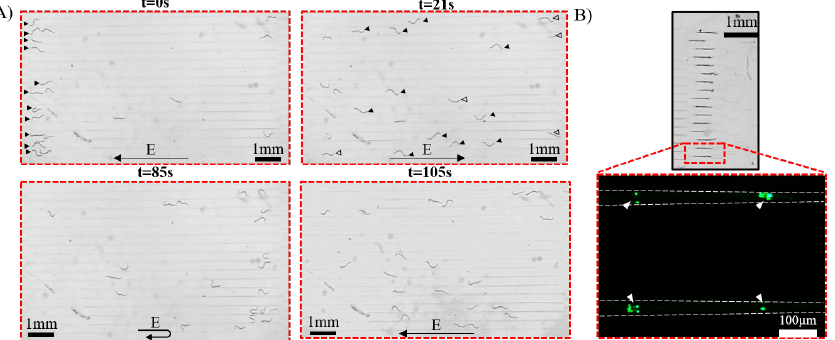
Figure 3. ( A ) Time-lapse images showing electrotaxis of N2 worms in parallel channels after exposure to 250 µ M 6-OHDA. Black arrows indicate worms responding towards the cathode, while empty arrows show worms with different phenotypes, such as uncoordinated movement and sudden freezing due to 6-OHDA exposure (EF = 3.7 V/cm). ( B ) Worms trapped in the tapered channels, with a zoom-in on two immobilized BZ555 worms, fluorescently imaged in a healthy state. Arrowheads are showing the dopaminergic neurons